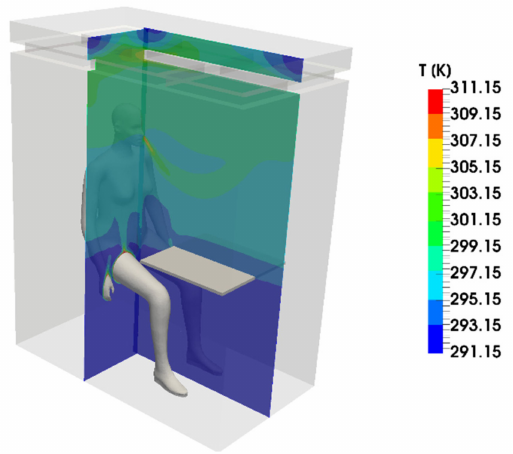
Figure 6. CFD simulation of the temperature field in the exposure